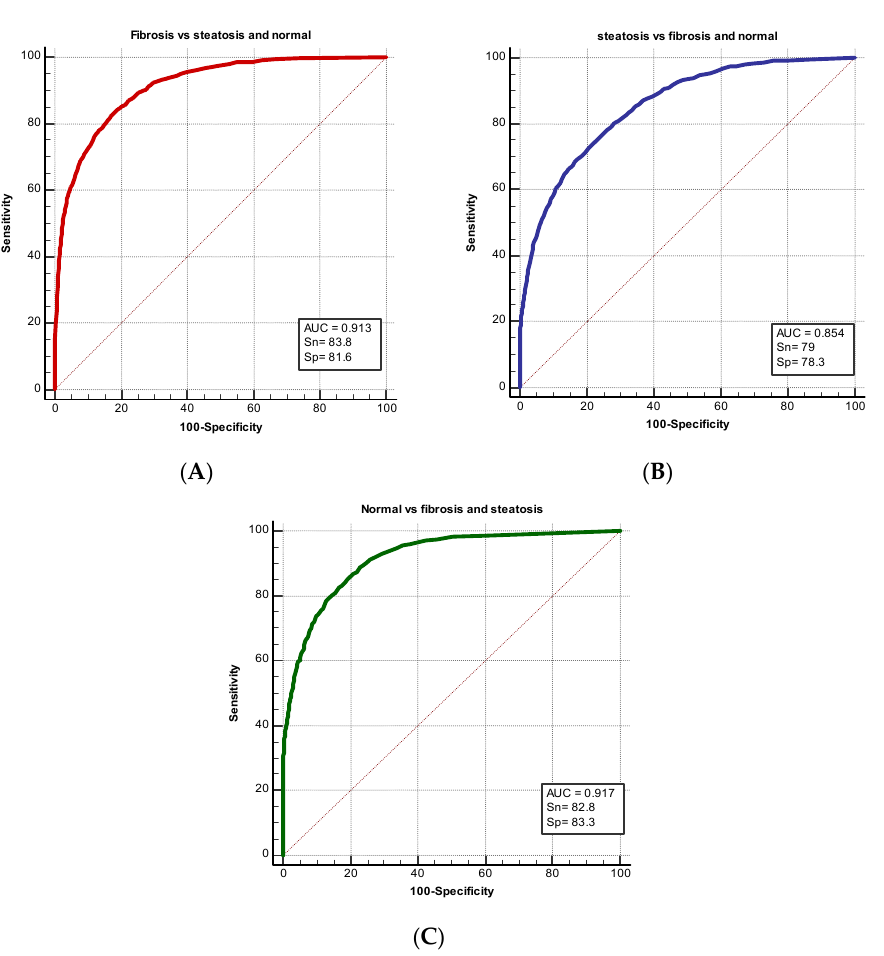
Figure 2. ROC curves of the diagnostic performance of quantitative liver texture ultrasound features using random forest machine learning for multicategory classification. ( A ) shows the diagnostic performance of ultrasound features in differentiating fibrosis from the two remaining groups: steatosis and normal. ( B ) demonstrates diagnostic performance in differentiating steatosis group from fibrosis and normal groups. ( C ) shows the performance of normal cases versus liver disease: fibrosis and steatosis. AUC refers to area under the curve, Sn: sensitivity, and Sp: specificity.